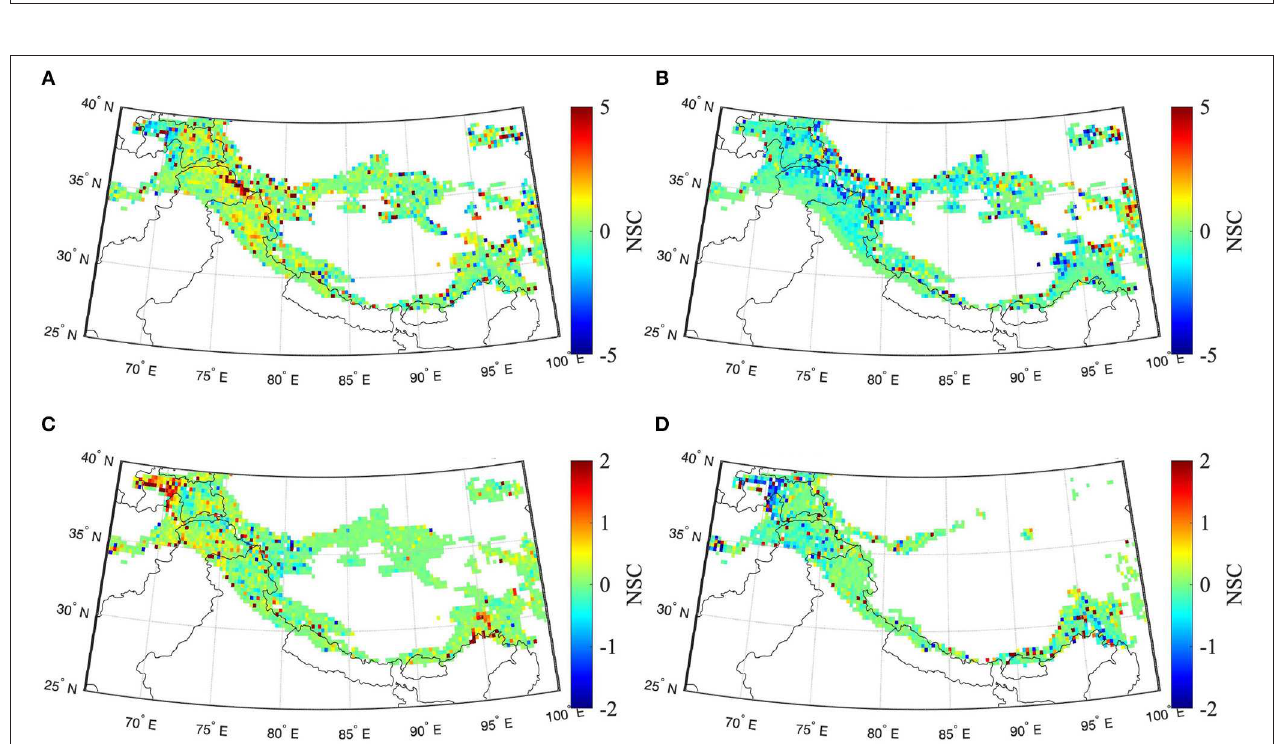
FIGURE 7 | Maps of NSCs from SVM-based predictions of 1 Tb 18.7–36.5 V averaged over the snow ablation months (Apr, May, Jun) from 2002 to 2011 for snow-covered areas in HMA. (A) Snow density [kg/m 3 ], (B) snow temp. (top layer) [K], (C) snow water equivalent [m], and (D) snow liq. water content [mm].